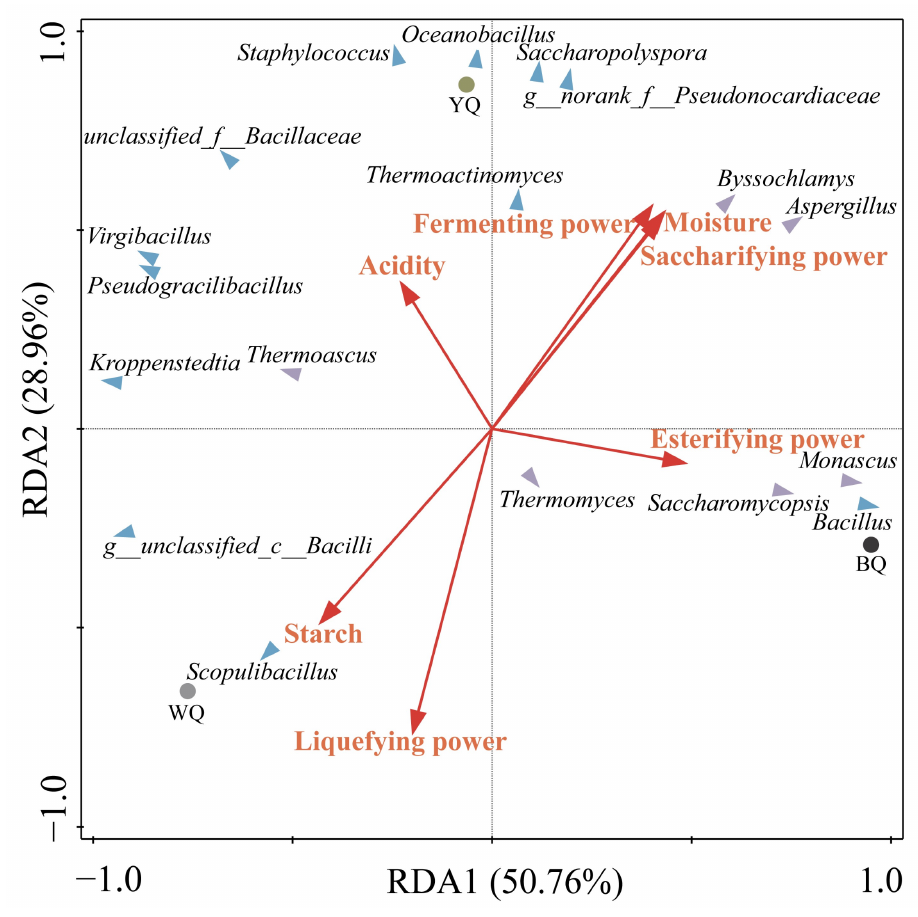
Figure 5. Redundancy analysis (RDA) of the different genera and physicochemical